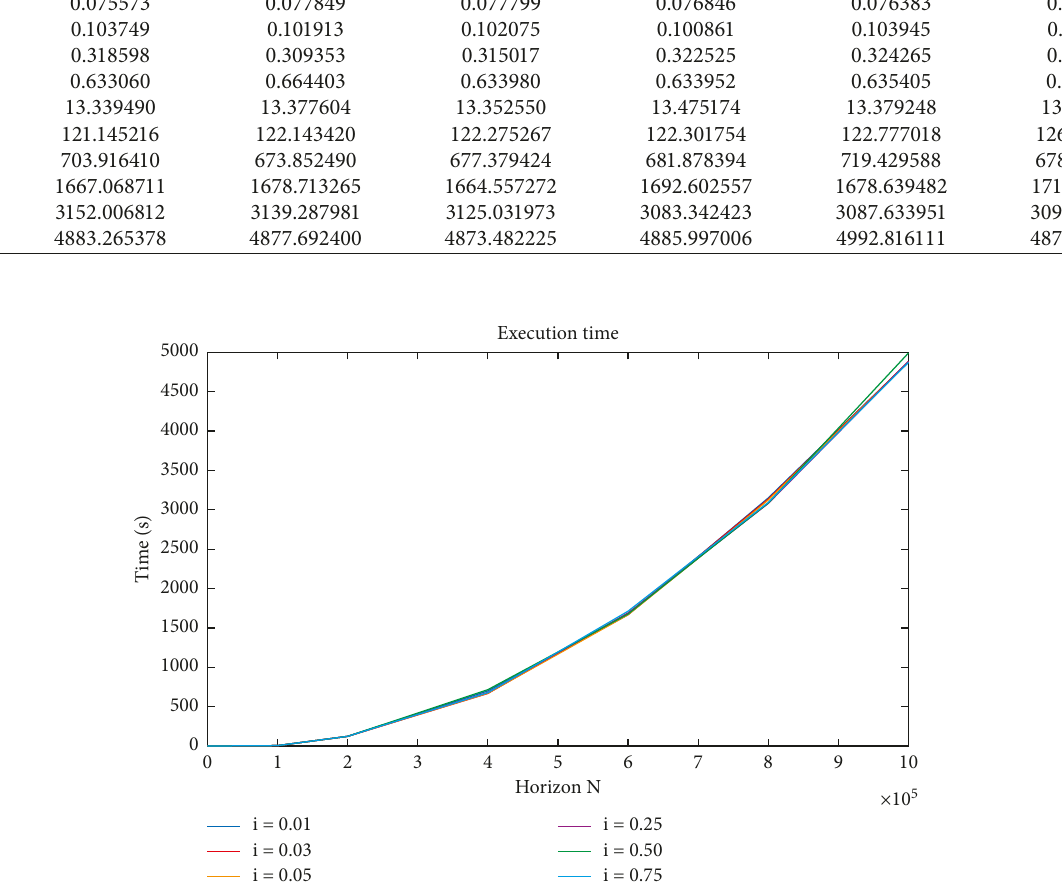
Figure 9: Execution time when initial capital is $ 1